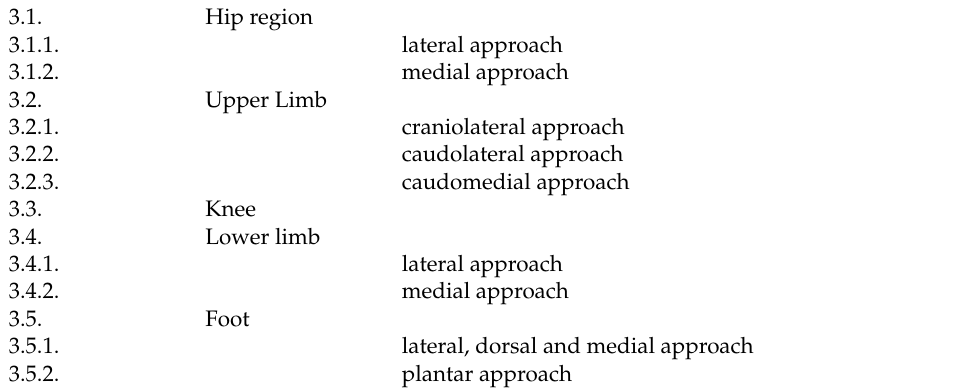
Table 1. Overview of the presented regions of the pelvic limb of the rhesus